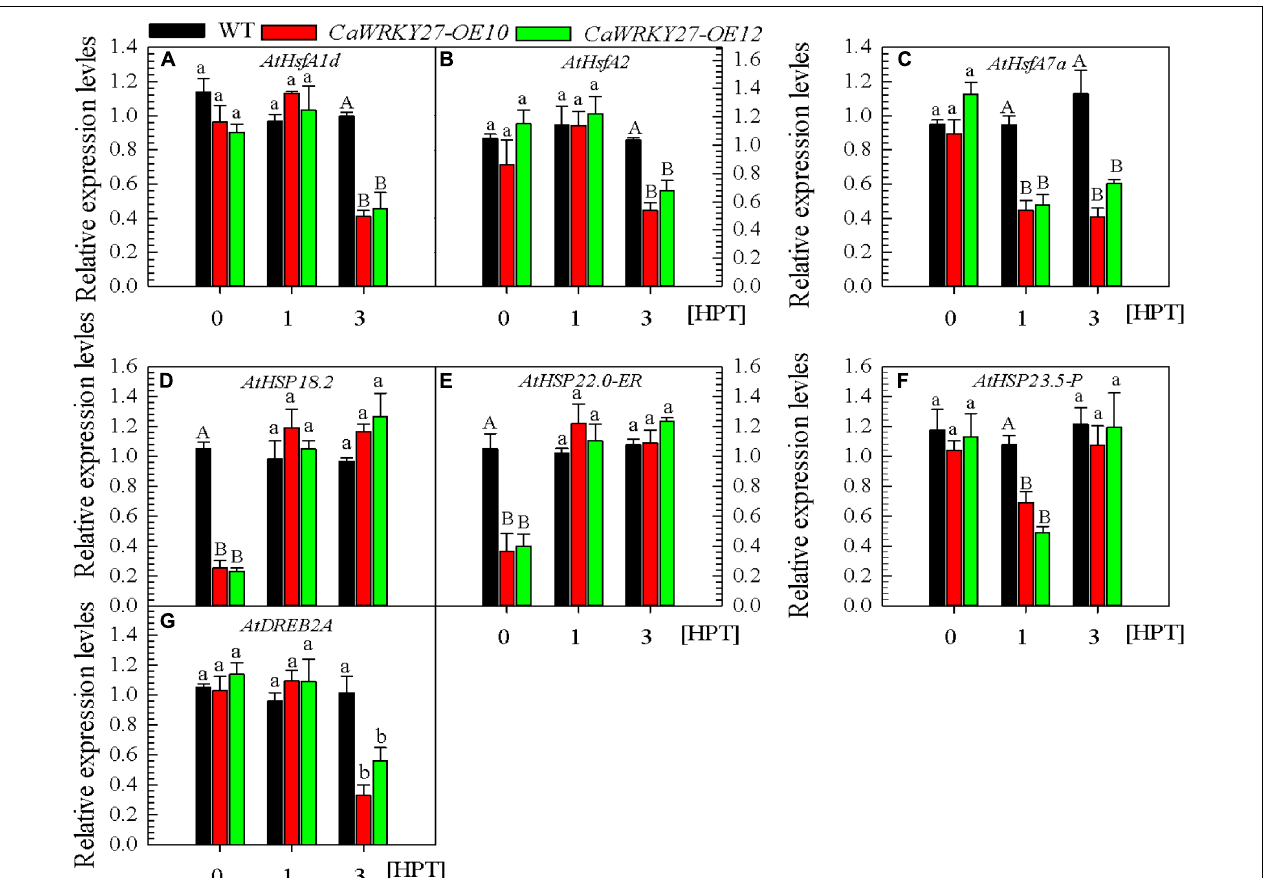
FIGURE 5 | Analysis of thermotolerance-responsive gene expression levels by qRT-PCR in CaWRKY27-OE10 , OE12 , and WT plants at 1 and 3 h post treatment with heat stress. (A–C) The relative transcript levels of heat stress response genes AtHsfA1d, AtHsfA2 , and AtHsfA7a. (D–F) The relative transcript levels of HSP genes AtHSP18.2 , AtHSP22.0-ER and AtHSP23.5-P . (G) The relative transcript levels of transcription factor AtDREB2A. The transcript levels of different gene were normalized against AtUBQ10 , followed with normalization against the gene in WT at 0 hpt. Data represent the mean ± SE of three biological replicates. Different letters indicate significant difference compared to WT ( SNK -test, lowercase difference P < 0.05 or uppercase difference P <